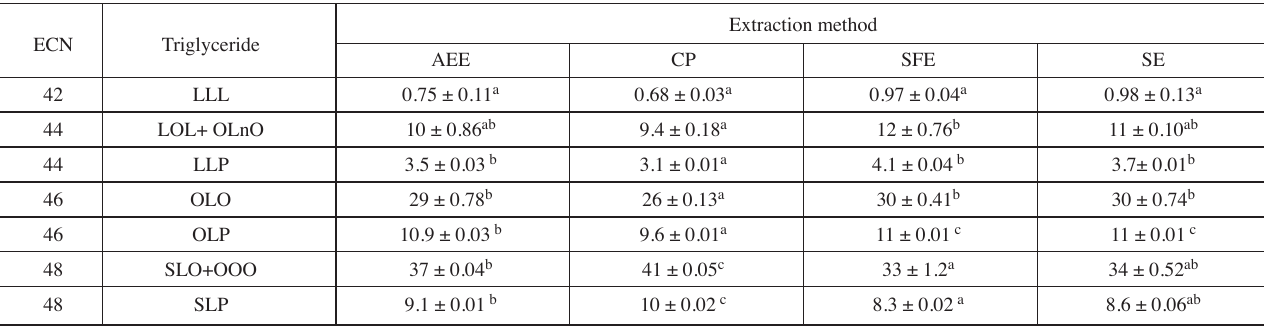
Tab. 3: Triglycerides content (%) found in A. pedunculatus seed oil obtained from different extraction methods